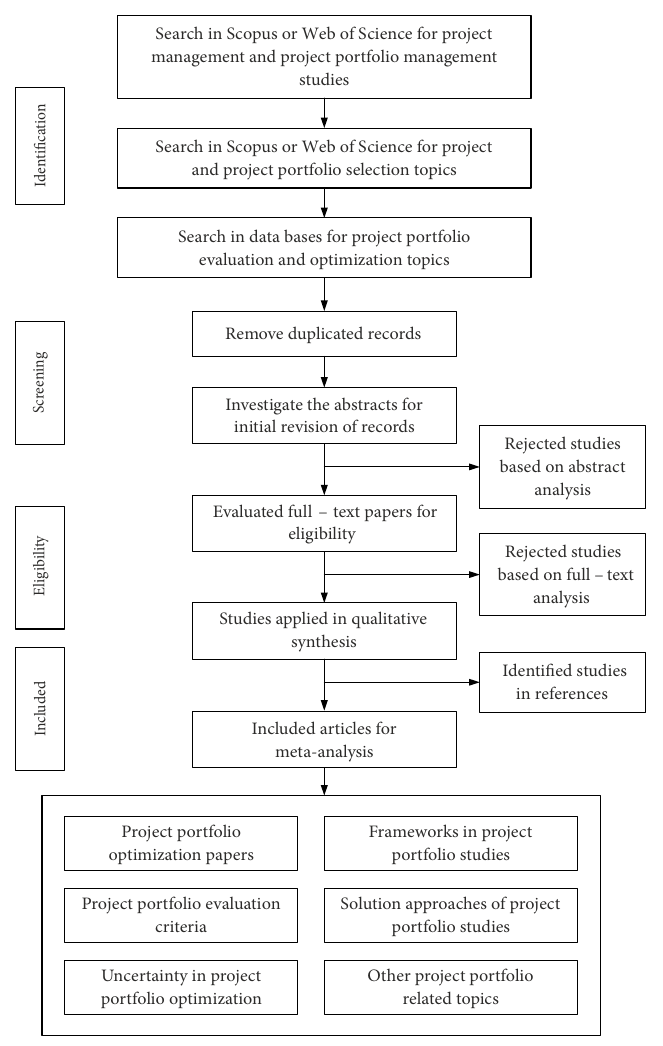
Figure 3. The study flowchart for the identification, screening, eligibility and included of